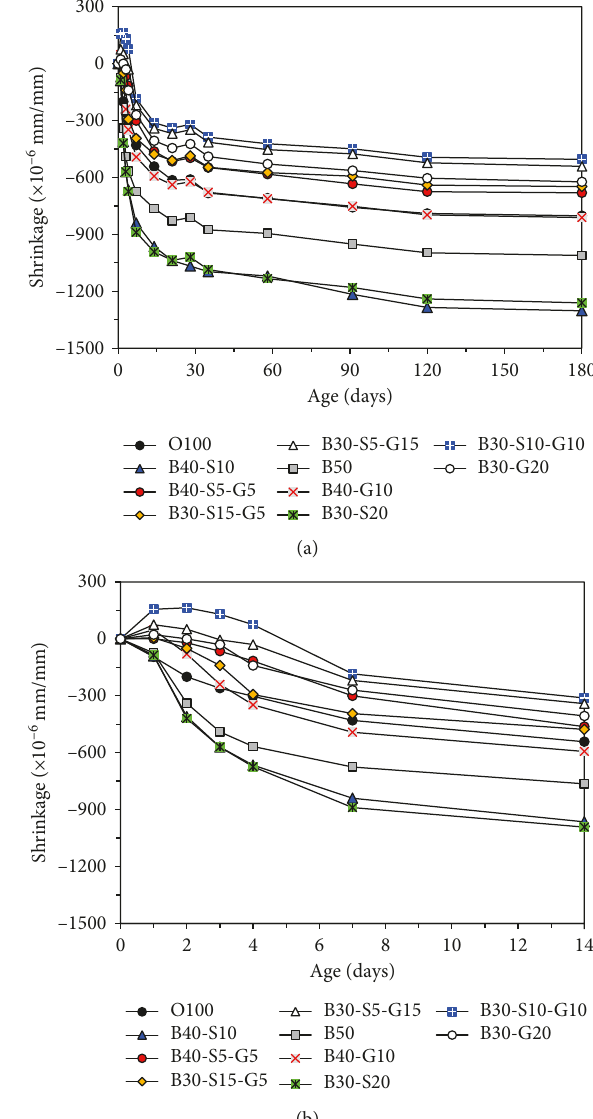
Figure 6: Drying shrinkage of paste specimens with binder types for (a) 180 days and (b) 14